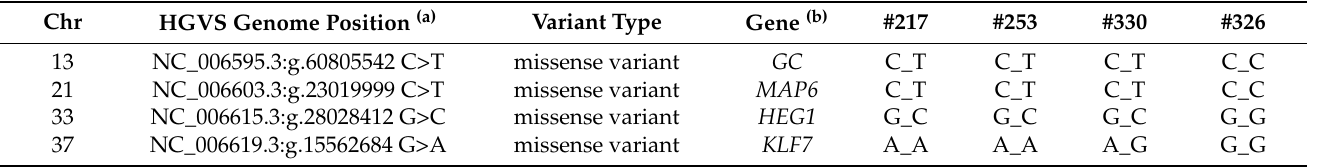
Table 3. Genotype information of four potential causative variants for ASCD deafness.